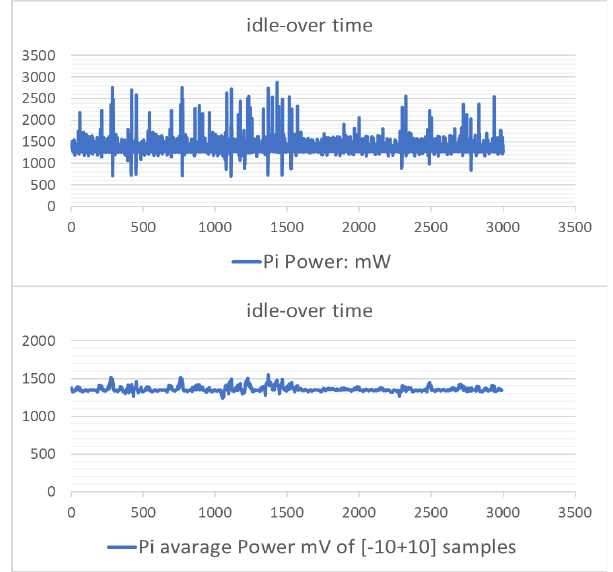
Figure 35. 1 h running Pi in idle mode.